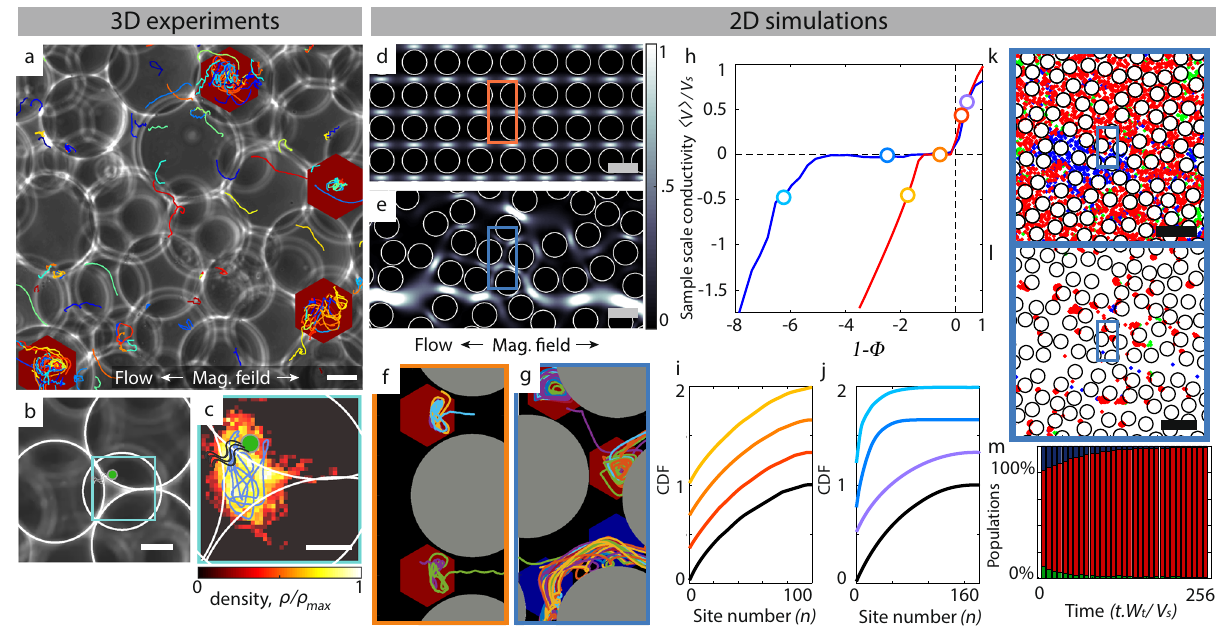
Fig. 4 Vortical trapping in disordered geometries of higher dimension. a Magnetotactic bacteria trajectories strongly localize in speci fi c pores (red hexagons) of a micro fl uidic packed bed of hydrogel beads. White arrows indicate magnetic fi eld (1.75mT) and mean fl ow directions. Scale bar, 10 μ m. b Sample pore containing a single, trapped cell (indicated by cell sketch). The tetrahedral pore is comprised of a triad of in-plane beads and one out of plane (center). Scale bar, 10 μ m. c Distribution of positions for a single localized cell, tracked for 6.5min (cyan square from b ; Supplementary Movie 5). The blue curve is a 20 s long sample segment of the trajectory, and the colormap indicates the cell ’ s distribution over time. Scale bar, 5 μ m. d , e , 2D fl ow fi elds through regular and disordered arrays of cylindrical pillars. f , g Cell trajectories in ordered and disordered media. Flow conditions correspond to colored boxes in ( f and g ) and red and blue markers in the sample scale trapping regime of ( h ), respectively. Red and blue hexagons mark local pores in the trapping and upstream regimes, respectively. h Sample scale conductivity 〈 V x 〉 / V s for ordered (red curve) and disordered (blue curve) geometries, as a function of the fl ow strength for steady-state transport conditions. For each curve, regimes with 〈 V 〉 / V ≈ [0.5,0, − 0.5] are marked by circles. i , j , Cumulative distribution x s functions (CDFs) of number of cells per trapping site (pore) in the ordered and disordered geometries, for Φ = 0 and 〈 V x 〉 / V s ≈ [0.5, 0, − 0.5]. Colors refer to speci fi c regimes marked in ( h ). CDFs are arti fi cially offset for clarity. k , l Location of cells for 〈 V x 〉 / V s = 0 in the disordered geometry for initial and steady- state conditions. Colored dots mark cells in the upstream (green), trapping (red), and downstream (blue) regimes. m Populations of cells in the upstream (green), trapping (red), and downstream (blue) regimes as a function of time for the disordered geometry for 〈 V x 〉 / V s =